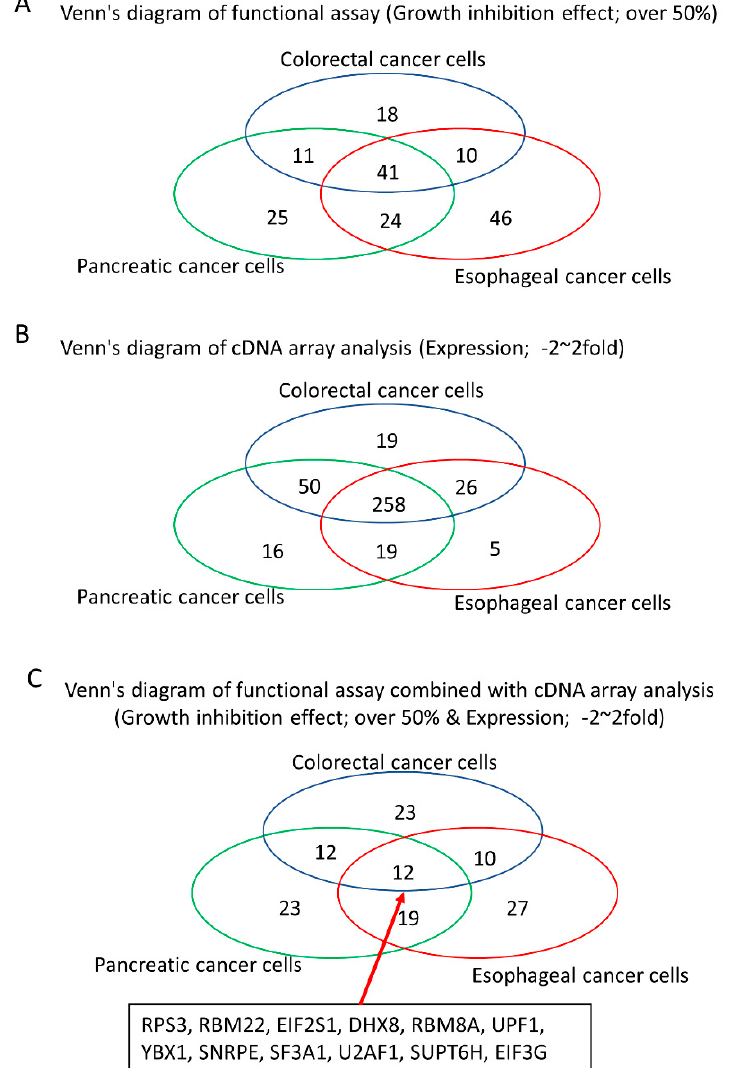
Figure 3. Venn diagram of the results of a functional analysis and cDNA microarray analysis. The functional ( A ) and expressional ( B ) overlap of colorectal cancer cells, pancreatic cancer cells and esophageal cancer cells is shown. Twelve RBPs were tumor-promotive RBPs without any expressional changes among cancer cell lines ( C ).